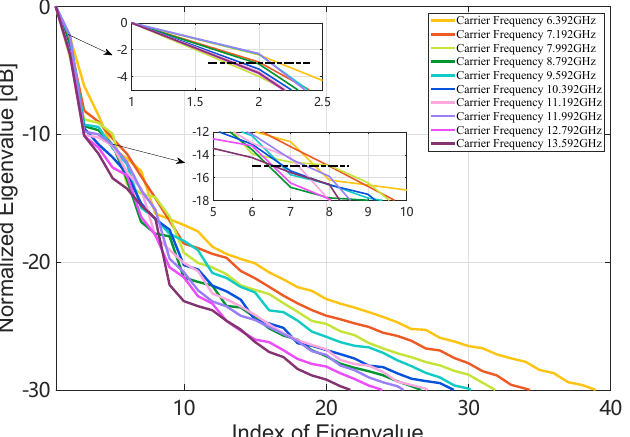
Figure 5. The normalized eigenvalues versus eigenvalue index obtained for different carrier frequen- cies at Position